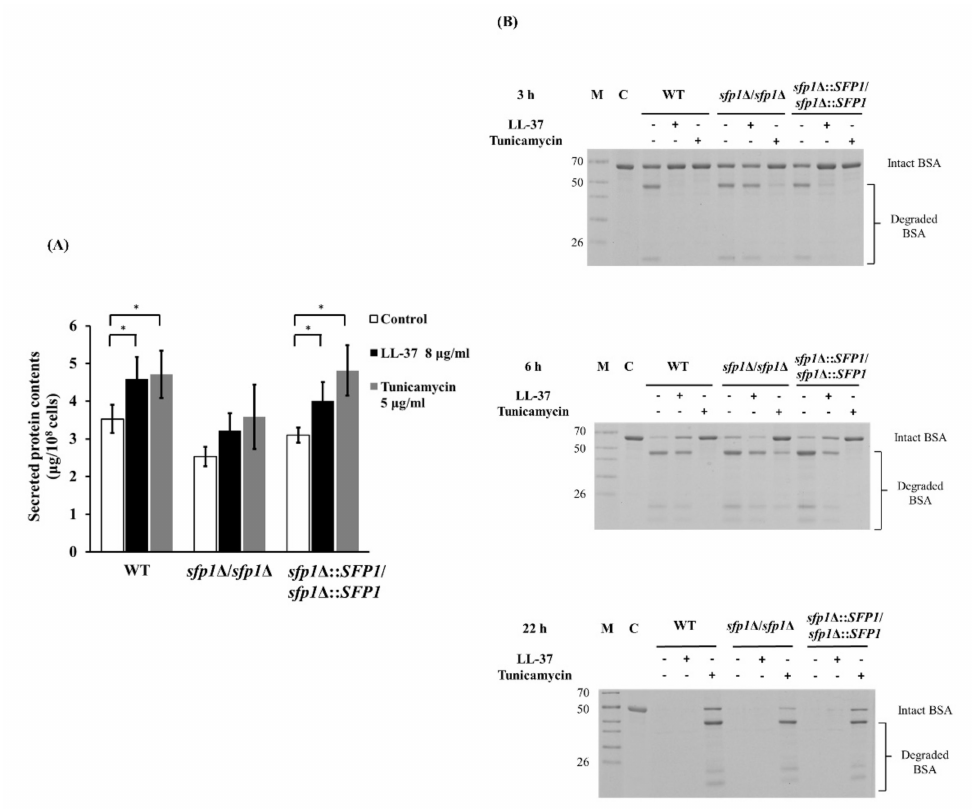
Figure 7. Effect of LL-37 and deletion of SFP1 on protein secretion and functional efficiency of secreted proteases. ( A ) After treatment with or without LL-37 and tunicamycin for 30 min, proteins in the supernatant were collected and quantified using the Bradford protein assay. The results are expressed as the mean ± SD of three independent assays. * p < 0.05. ( B ) To determine the efficiency of secreted proteases, BSA degradation was assessed. Cells pretreated with or without LL-37 (8 µ g/mL) and tunicamycin (5 µ g/mL) were incubated with BSA for 3, 6 and 22 h at 30 ◦ C. Equal amounts of cell suspension were analyzed by 12% SDS–PAGE, and proteins were visualized by Coomassie blue staining. M: protein marker ladder (kDa); C: control (BSA alone). The data are representative of three independent experiments with identical